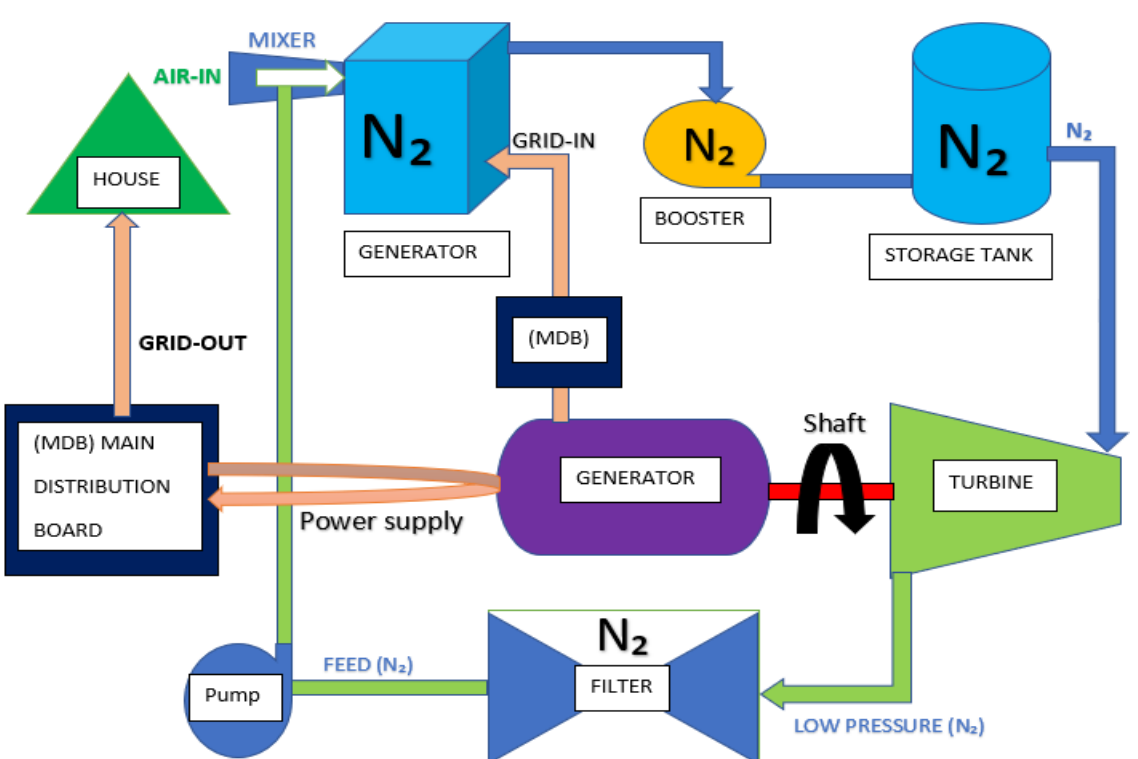
Figure 3. Schematic conceptual model of the nitrogen turbine engine system (NTES).